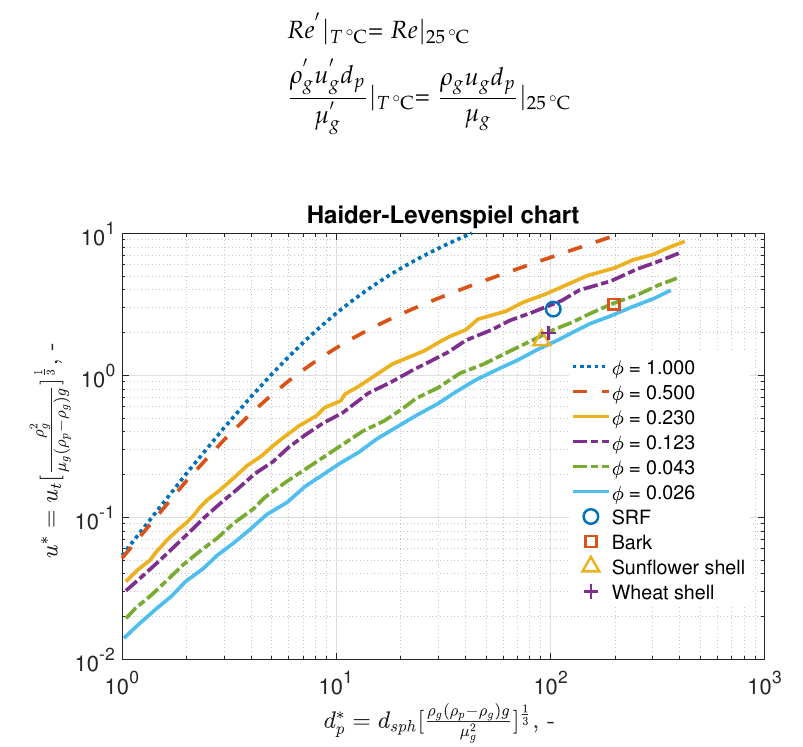
Figure 7. The Haider and Levenspiel [29] terminal velocity curves and the mean points (@ 50% entrainment) of the investigated renewable fuels for determining their characteristic sphericity values.